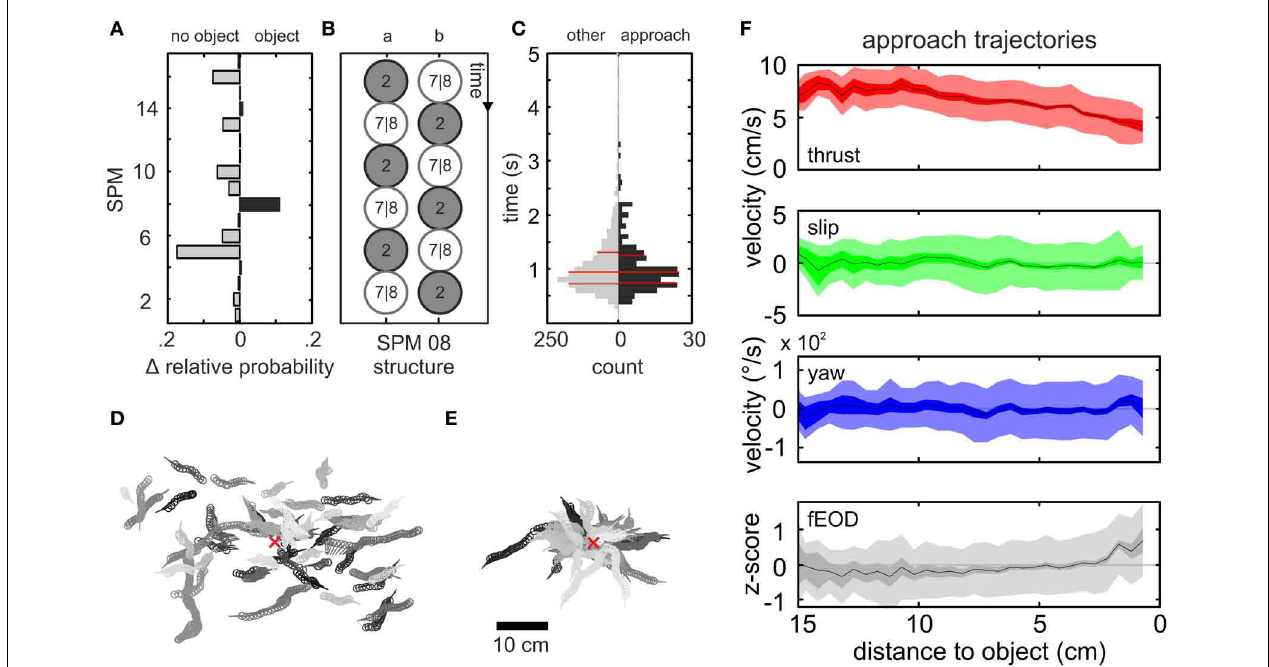
FIGURE 5 | Spatial and kinematic characterization of the “object approach”pattern.(A) Differenceinrelativeprobabilityofoccurrenceofthe17 SPMs for data without (left) and with object (right) presented in the tank. Most SPMs occurred equally likely for both conditions, while some had a higher probabilityofoccurrenceinabsenceofanobject.OnlySPM08wasfoundmore frequently when an object was present and hence was further explored. (B) Schematic showing the different possible structures of SPM 08. Constant PM segmentswerereducedtoasingleframerepresentedbythecirclesinorderto illustrate the inter-PM transitions. (C) Distribution of the duration of all SPM 08 chains.ThedatawassplitintoSPMsinwhichtheobjectwasapproached(black histogram, n = 4599 frames) and all remaining sequences of the SPM (gray histogram, n = 34436 frames). The distributions were indistinguishable and showed similar medians (thick red line, percentiles = thinner red lines). (D , E) Lollipop representation (dot = head position; handle = body orientation) of 50